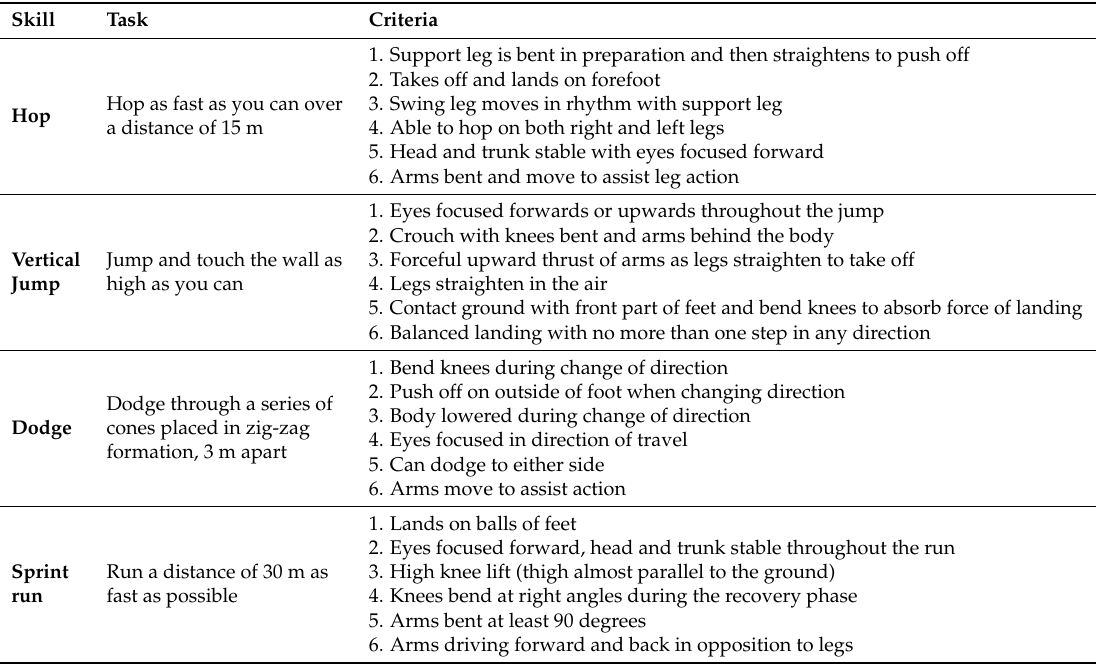
Table 1. Fundamental movement skill test battery and assessment